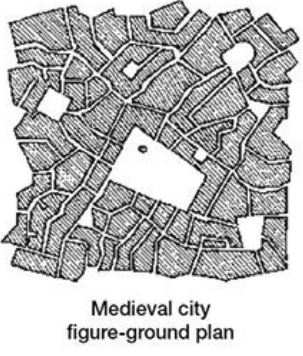
Figure 6. Space integration representing Mobility, Connectivity, Access and Spatial System.